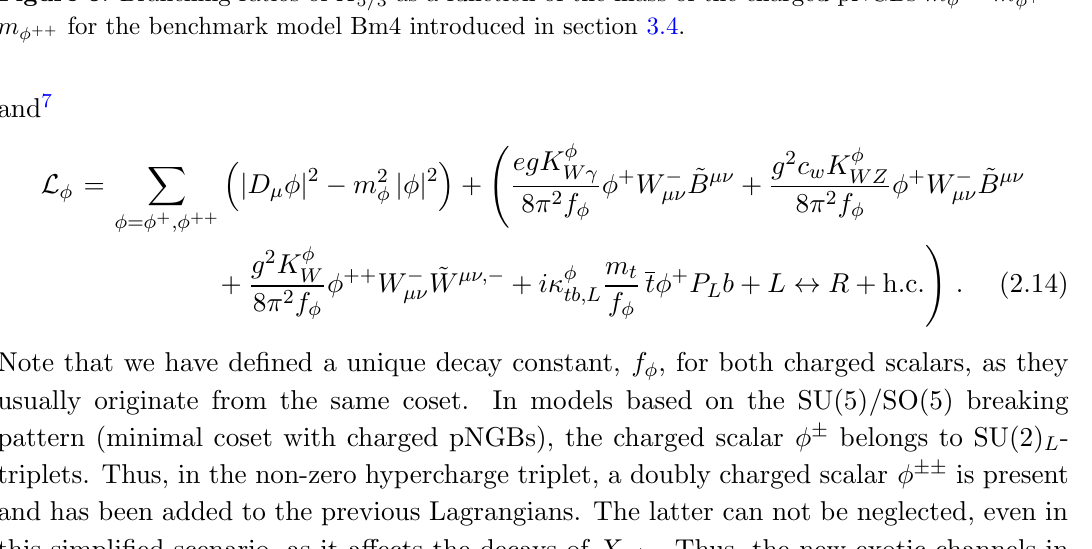
as a function of the mass of the charged pNGBs m (cid:30) = m 5 = 3